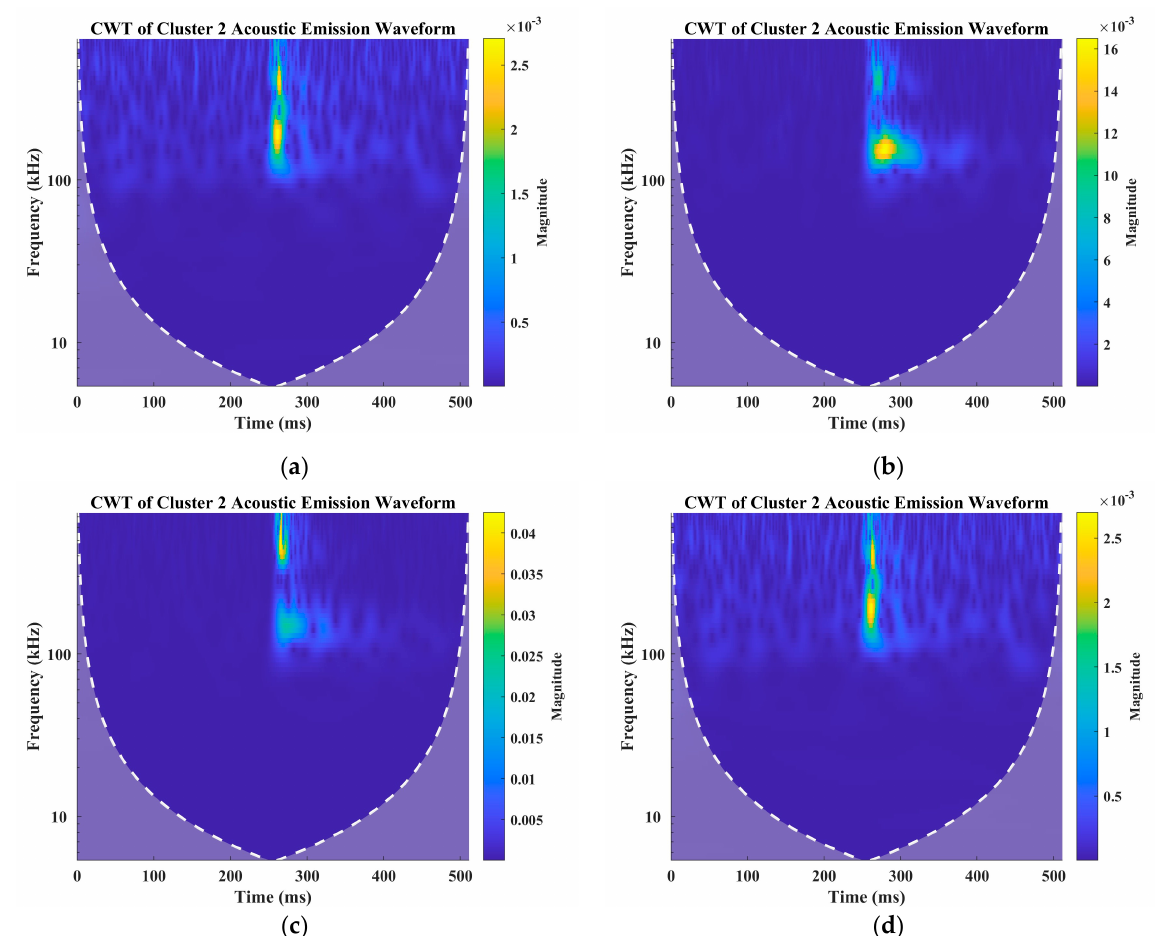
Figure A3. CWT spectrograms of four randomly selected AE signals ( a ) Signal 1; ( b ) Signal 2; ( c ) Signal 3; ( d ) Signal 4 from Cluster 2.